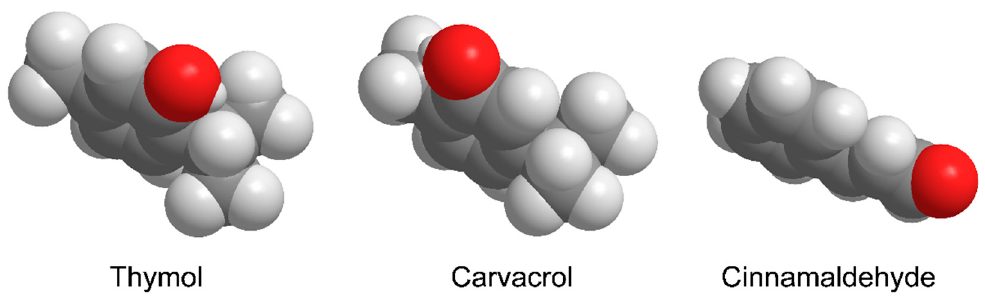
Figure 4. ChemDraw 3D MM2 energy-minimized model showing the 3D structure of thymol, carvacrol and cinnamalde- hyde.